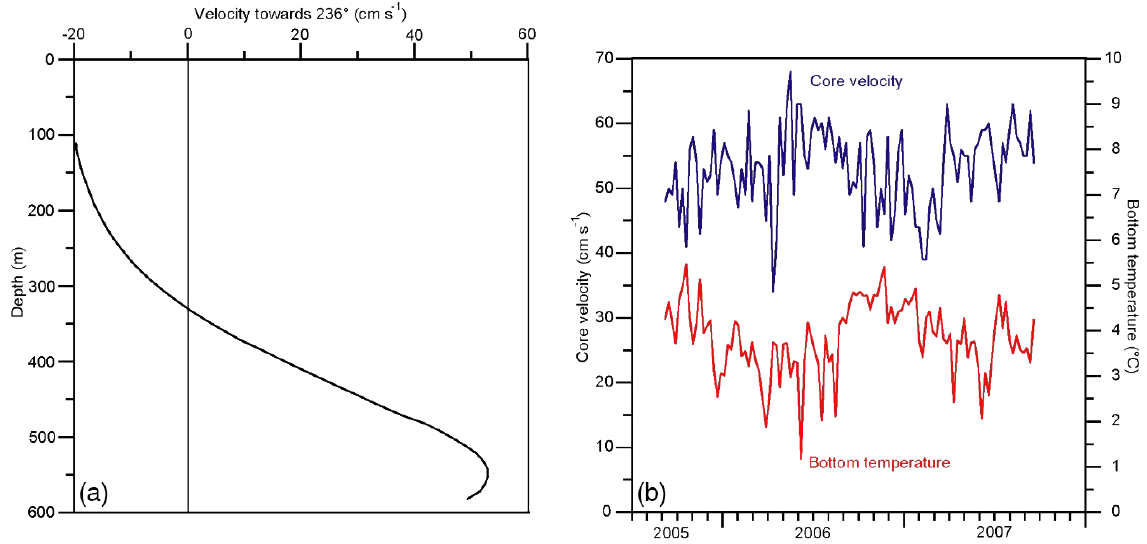
Figure 8. Results from the ADCP at site IFRI (Fig. 1a). Vectorially averaged velocity profile towards 236 ◦ (a) . Weekly averaged velocity towards 236 ◦ for bin 4, approximately 60m above the bottom (blue) and weekly averaged bottom temperature (red) (b) .